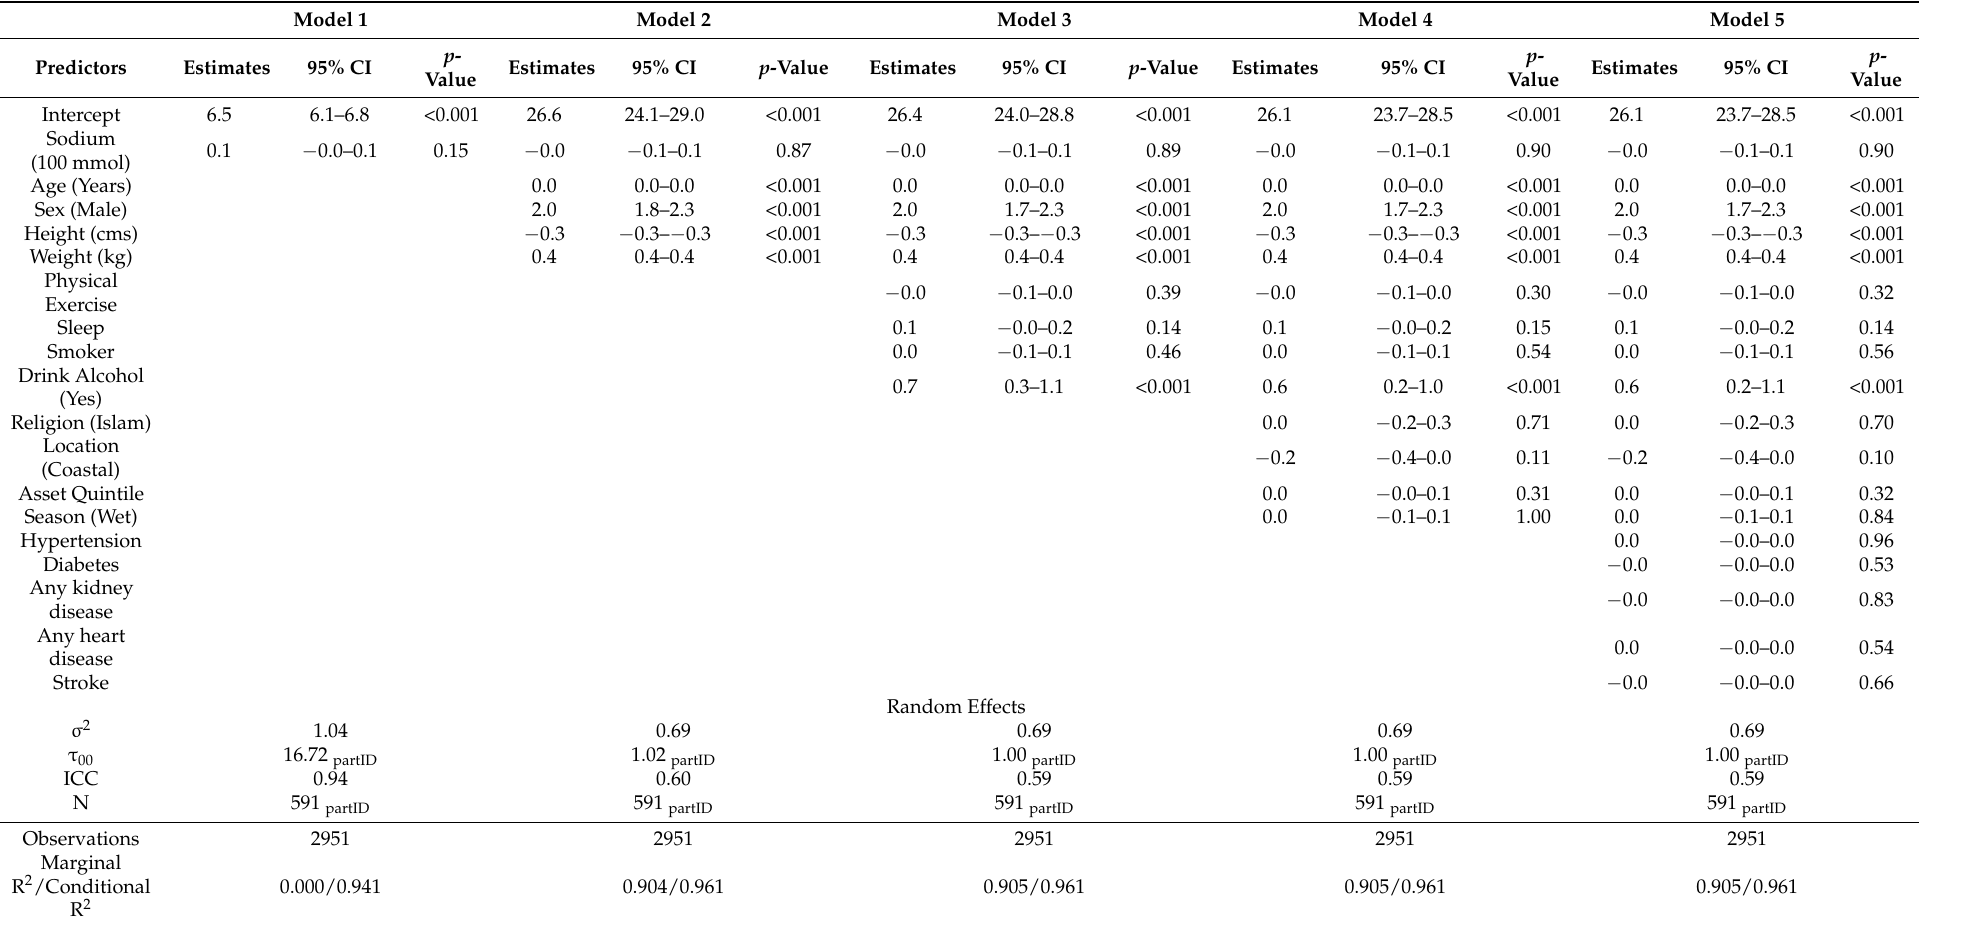
Table 7. Association between 24 h urinary sodium and mean visceral fat